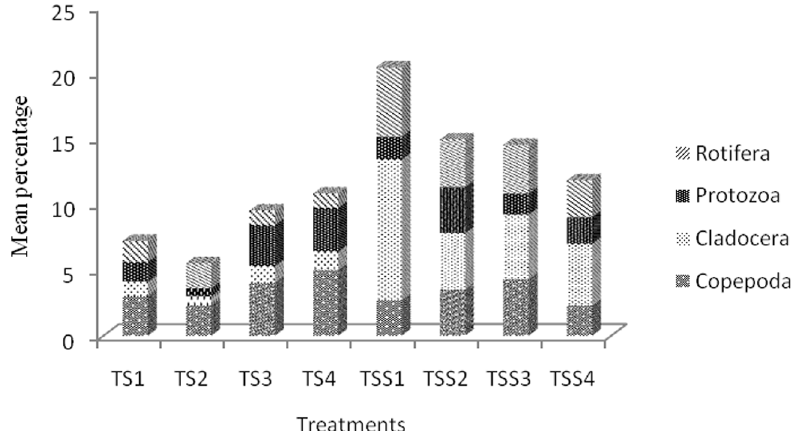
Fig. 4. Percentage compositions of animal assemblages at surface (TS1 – TS4) and subsurface (TSS1 – TSS4) levels of waters of ponds under four different treatments during the study period.